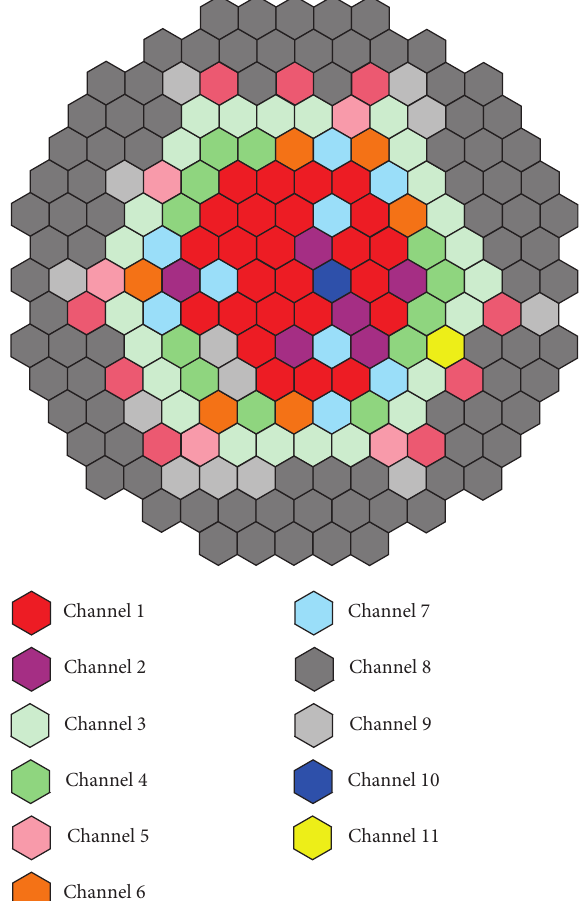
Figure 8: SAC-3D channel layout for FFTF core.